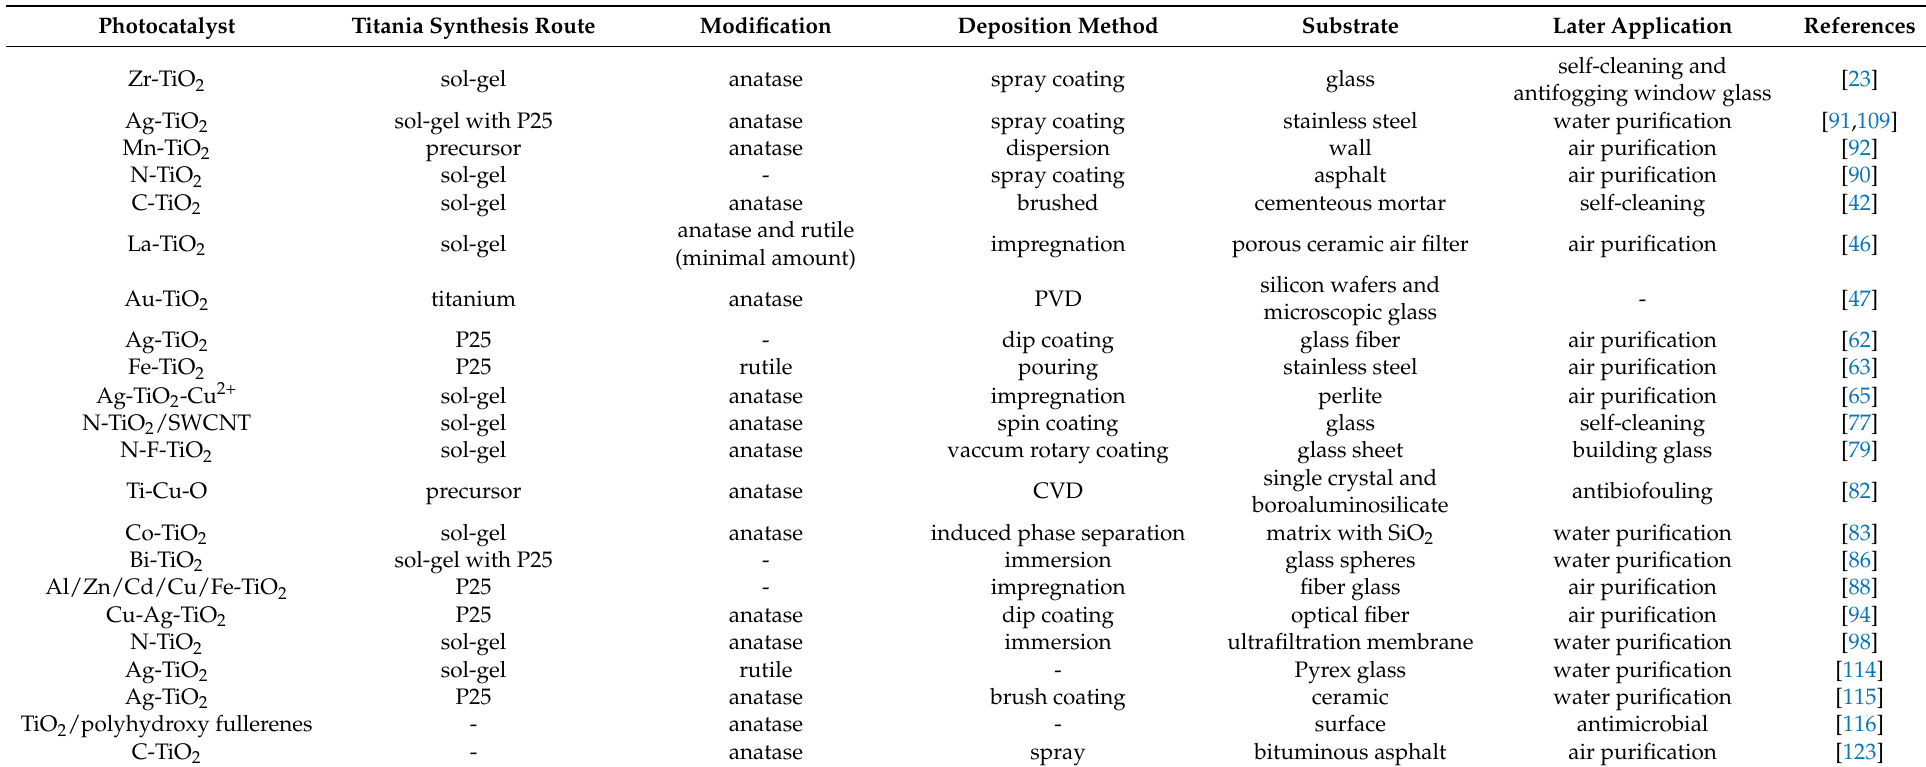
Table 2. Synthesis methods, obtained titania modifications (if known), deposition technique, and anticipated application for doped or modified TiO 2